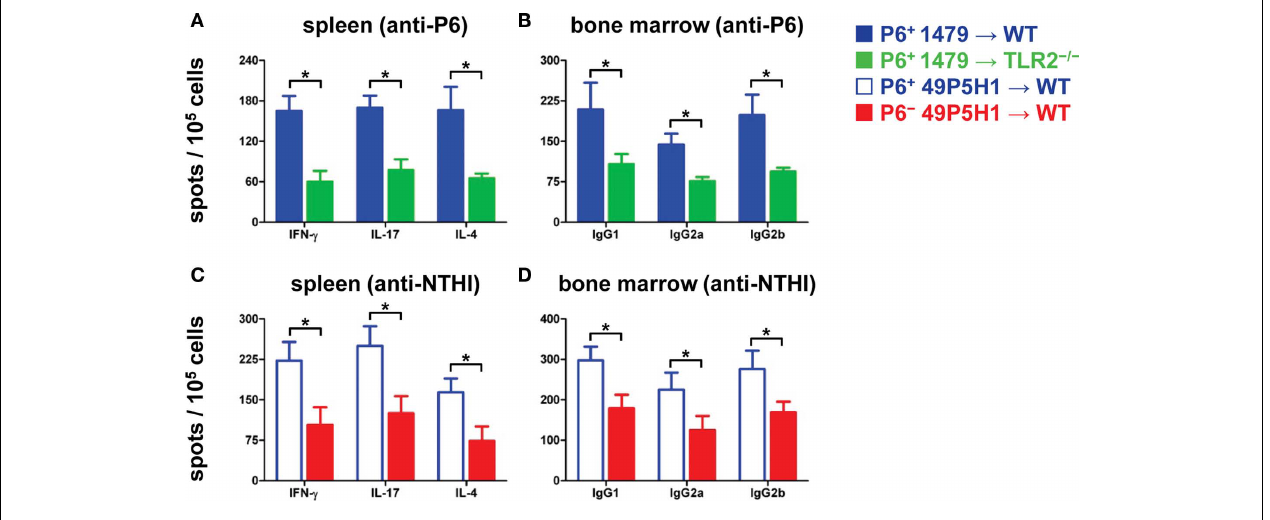
FIGURE 3 | Frequency of antigen-specific immune cells in lymphoid organs. ELISPOT to measure frequency of IFN- γ -, IL-17-, IL-4-secretingT cells (A,C) and frequency of IgG1-, IgG2a-, IgG2b-secreting B cells (B,D) from mice